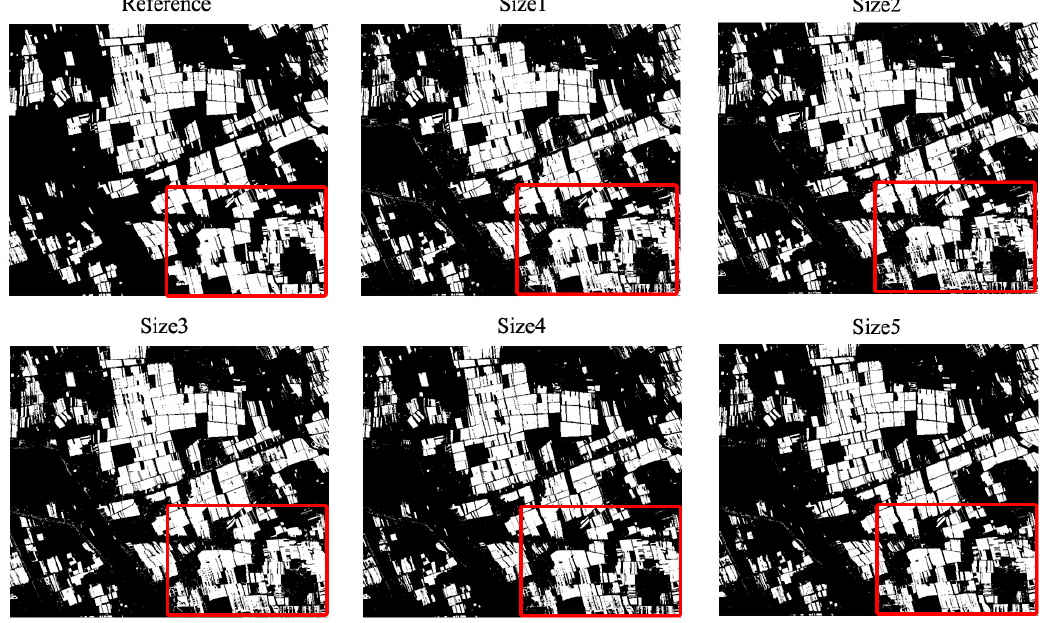
Figure 7. Comparison of SVDD classification results for wheat over different window sizes using simulated 10-m resolution image. The ground data are also included as reference. Table 3. Accuracy assessment for each classification at different spatial patterns and window sizes.